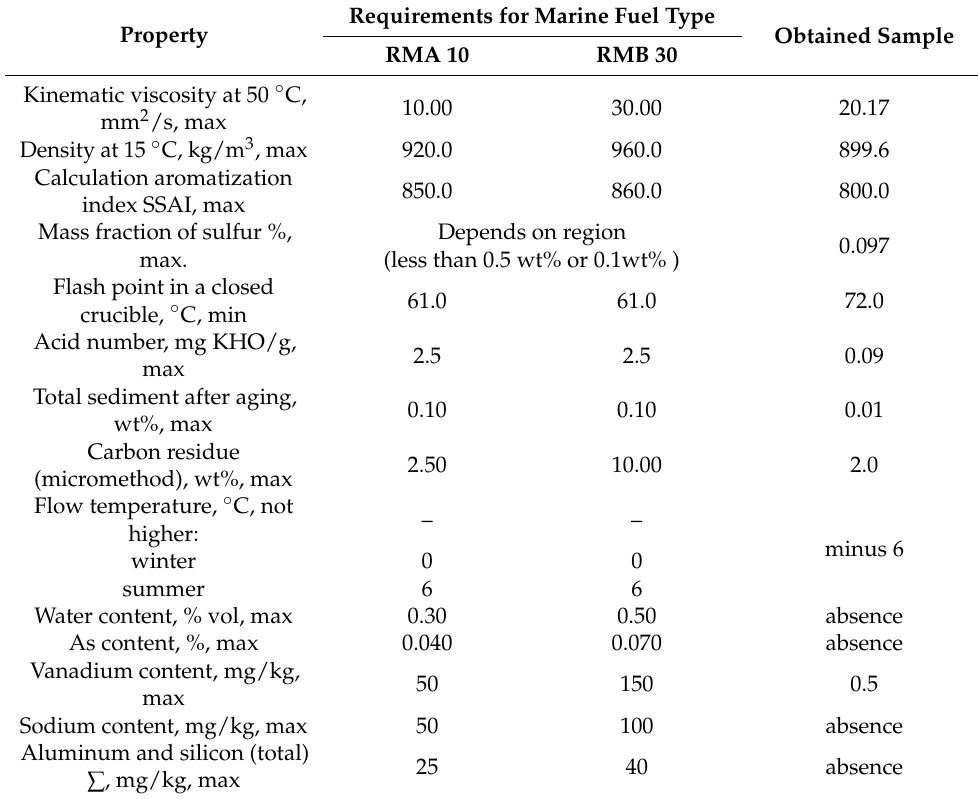
Table 6. Characteristics of hydrotreated adsorptive treatment atmospheric residue.